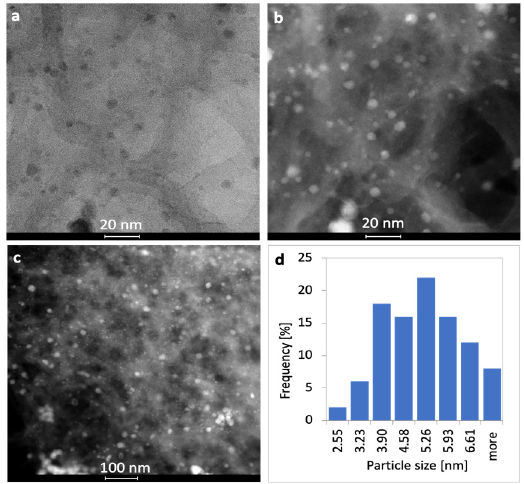
Figure 3. Bright field ( a ) and dark field ( b , c ) TEM pictures of Ni/CNT with Ni particle size distribution ( d ).